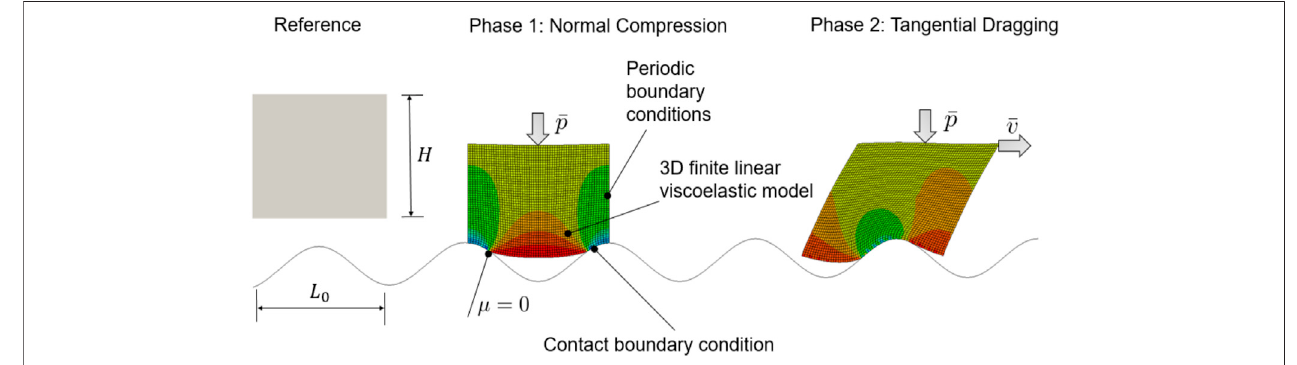
FIGURE 4 | Micromechanical testing scheme.